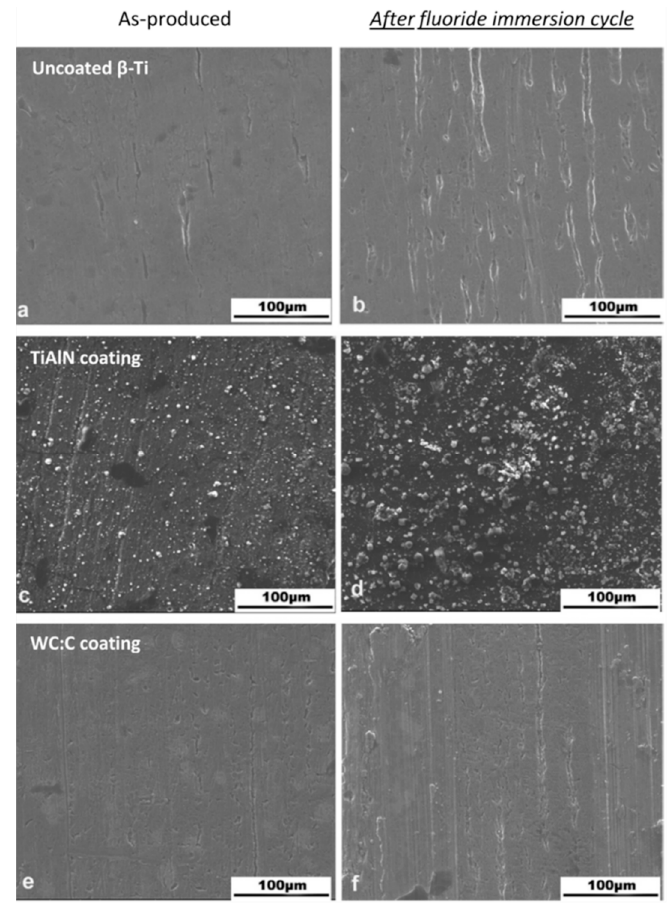
Figure 8. Surface analysis of (a and b) uncoated β -Ti alloy, (c and d)TiAlN, and (e and f) WC:C coatings (a, c and e) before and (b, d, and f)after a fluoride immersion cycle. Adapted from [ 101 ] .